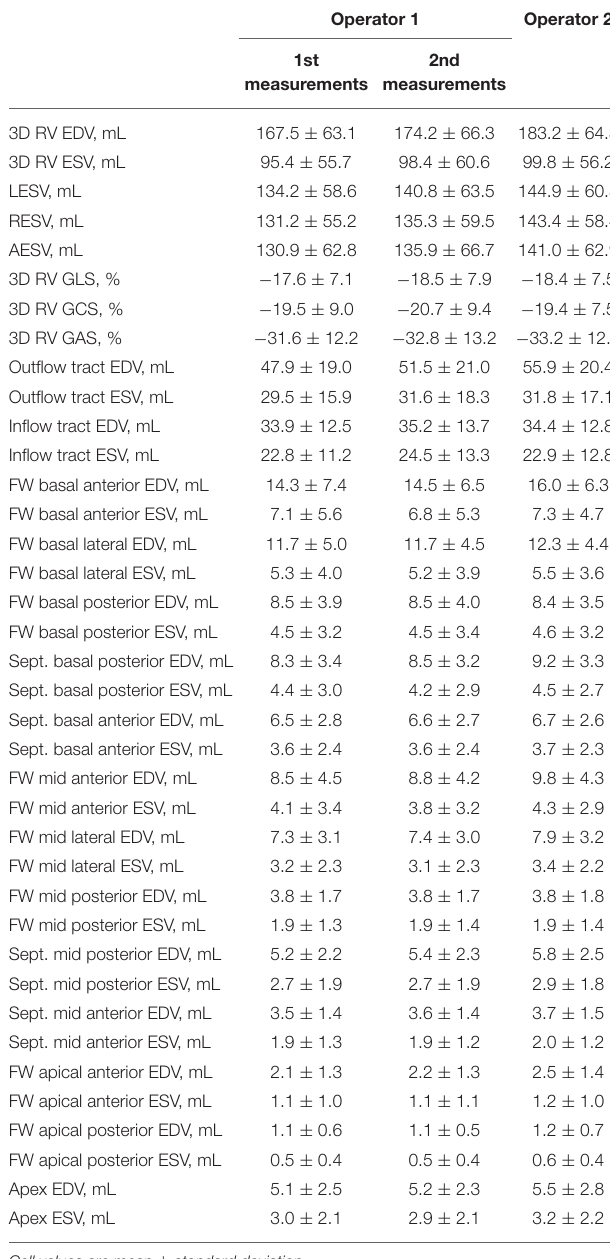
TABLE 1 | 3D echocardiographic parameters measured by the two operators in the reproducibility analysis.